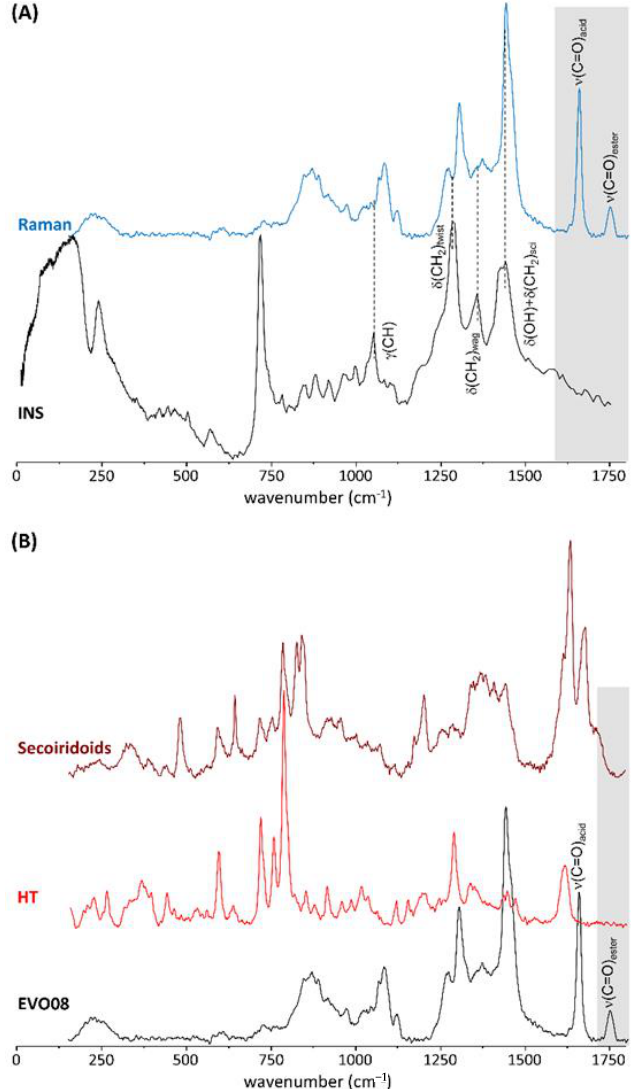
Figure 4. ( A )—INS and Raman spectra (0–1750 cm − 1 ) of extra virgin olive oil (EVOO8); ( B )—Raman Figure 4. ( A ) — INS and Raman spectra (0 – 1750 cm −1 ) of extra virgin olive oil (EVOO8); ( B ) — Ra- man spectra (0 – 1750 cm −1 ) of EVOO8 and the reference compounds hydroxytyrosol and secoir- spectra (0–1750 cm − 1 ) of EVOO8 and the reference compounds hydroxytyrosol and idoids. Table 2. Raman intensity ratios for the bands at 1655 and 1747 cm −1 ( ν C = O from phenolic acids and esters, respectively), for the extra virgin olive oils and sunflower oil in the present study.